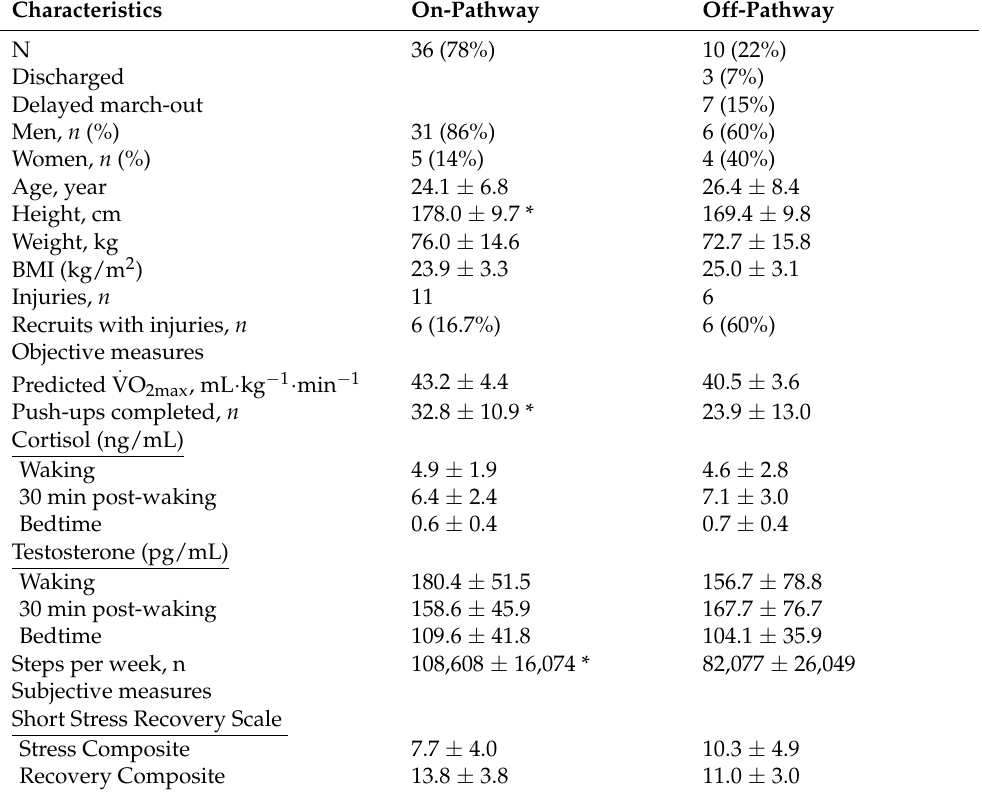
Table 1. Recruit characteristics at week 1 of